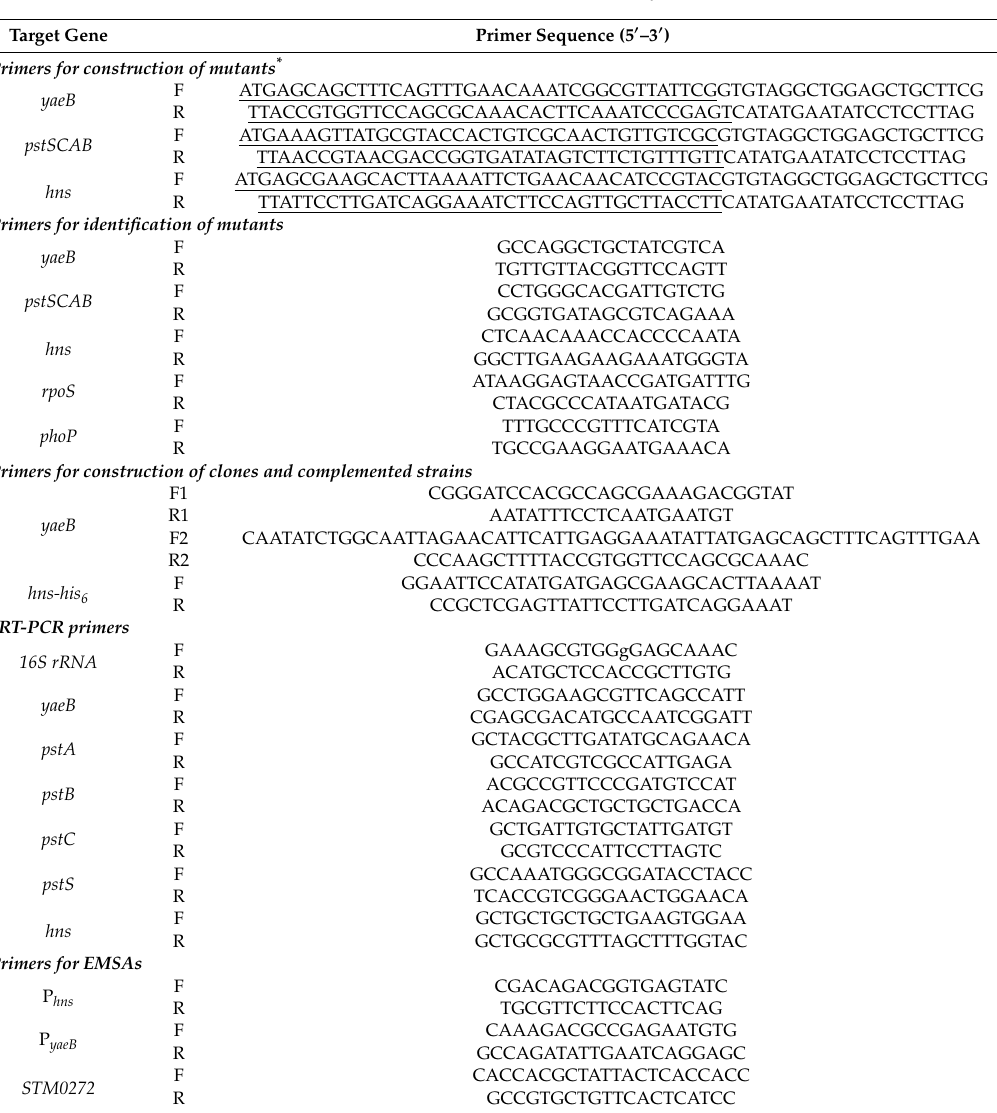
Table 2. Primers used in this